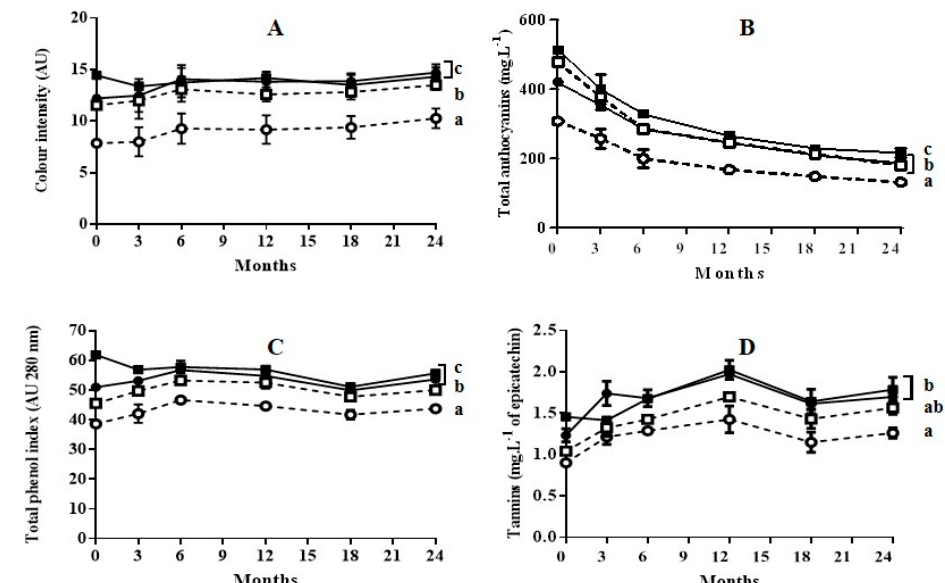
Figure 3. Evolution of color intensity ( A ), total anthocyanins ( B ), total phenol index ( C ), and tannins ( D ) of wines during 6 months of aging in oak barrels plus 18 months of aging in bottles. ( ○ ) wine obtained from untreated grapes with 3 days of maceration; ( ● ): wine obtained from PEF-treated grapes with 3 days of maceration; ( □ ): wine obtained from untreated grapes with 6 days of maceration; ( ■ ): wine obtained from PEF-treated grapes with 6 day of maceration. Different letters represent significant differences according to one-way ANOVA analysis ( p < 0.05).